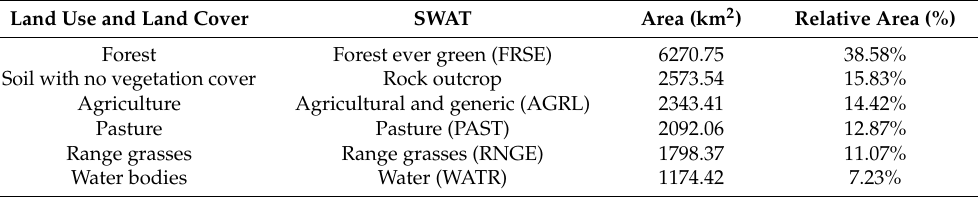
Table 1. Types of land use and land coverage found in the basin.